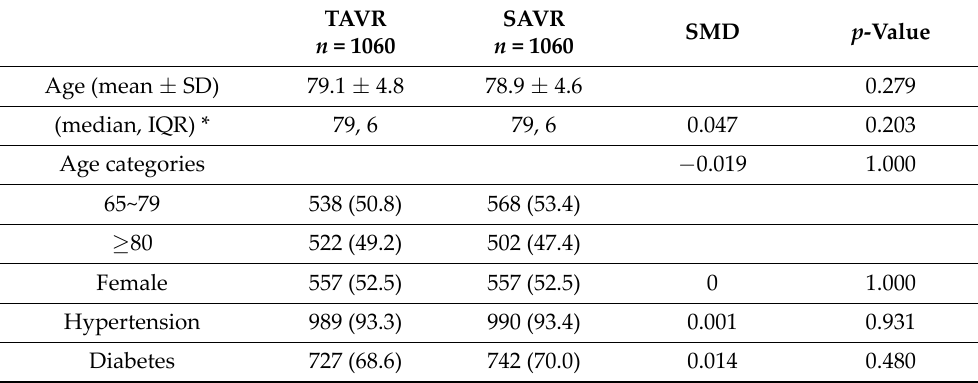
Table 1. Baseline characteristics of patients after propensity score